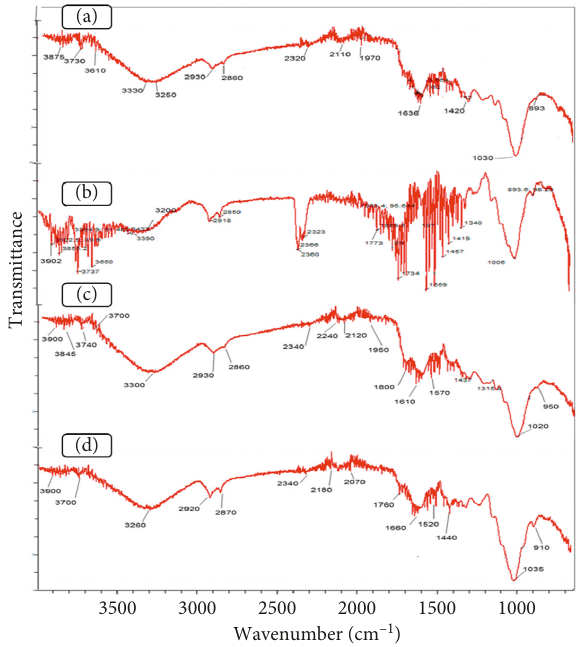
Figure 7: FT-IR spectra after adsorption of RAD and